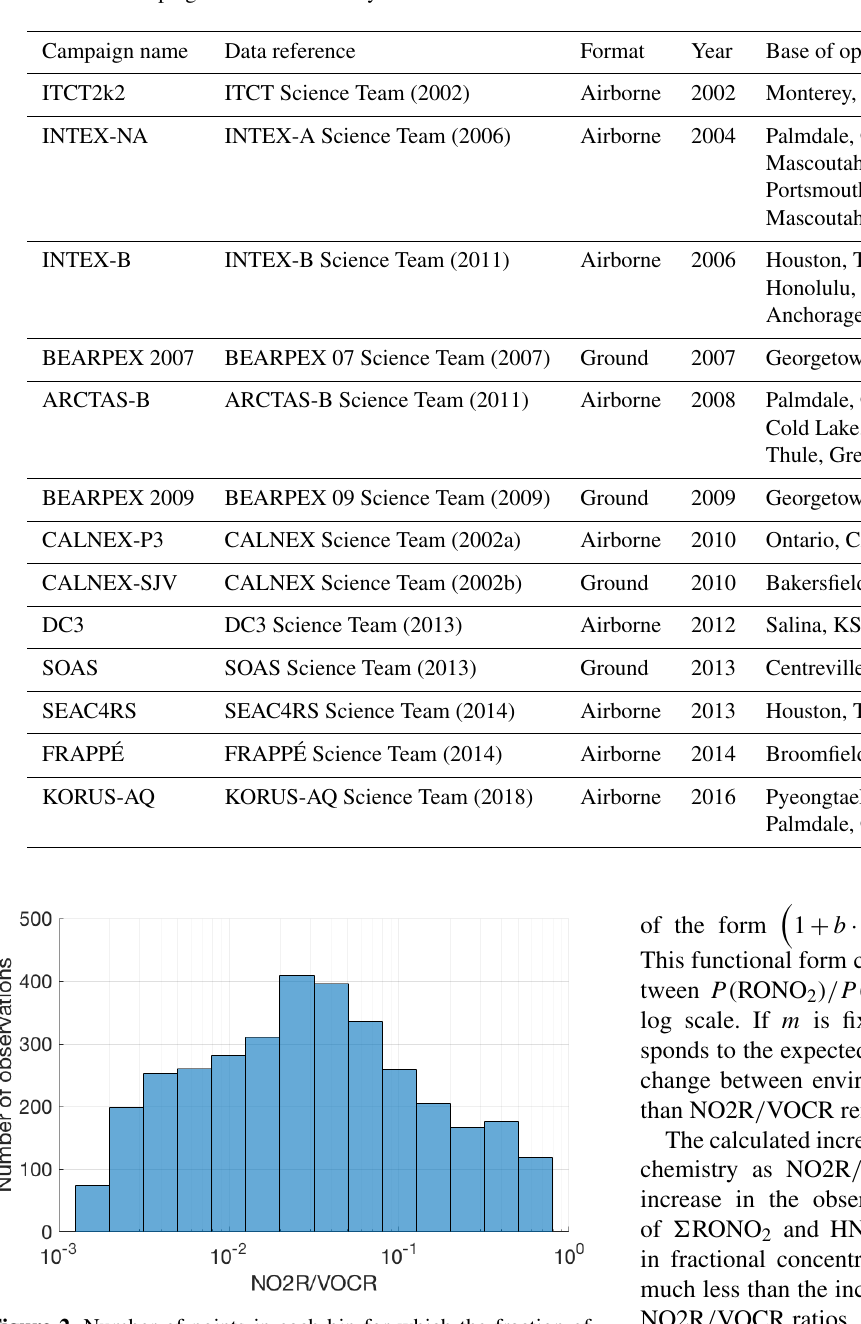
Table 1. Field campaigns used in this analysis